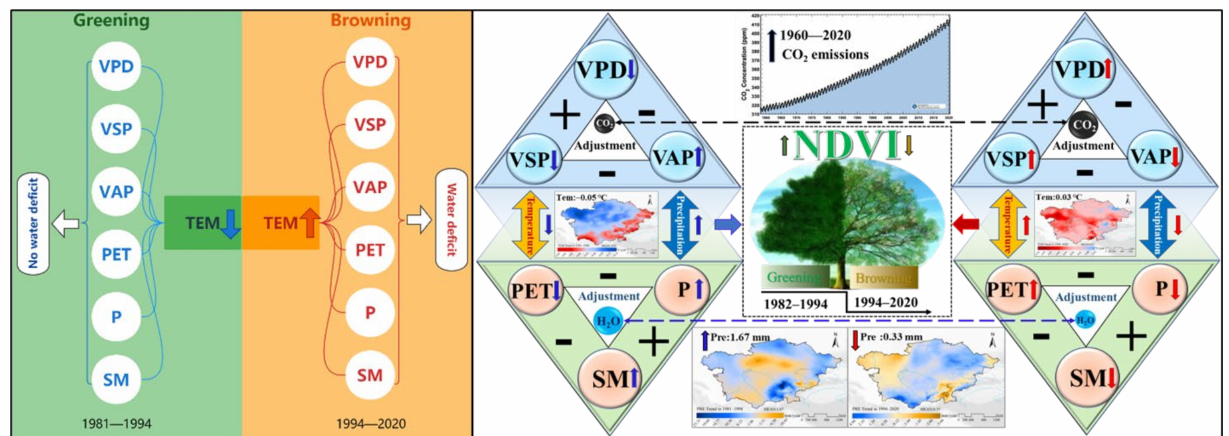
Figure 11. Analytical diagram of NDVI spatiotemporal variation mechanism. The graph